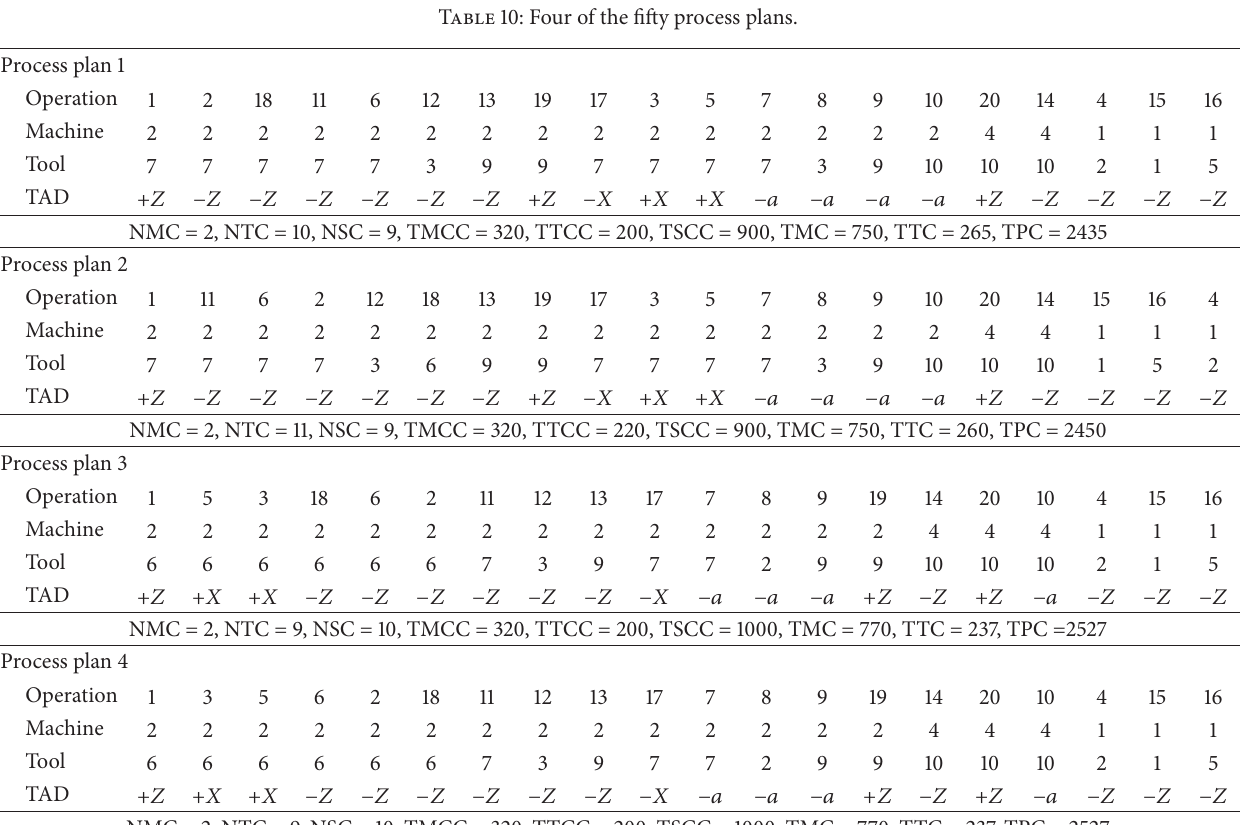
Table 10: Four of the fifty process